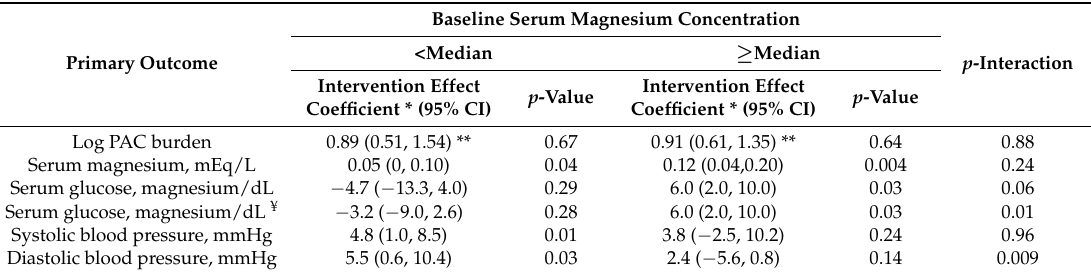
Table 4. Change in PACs and secondary endpoints (i.e., SBP, DBP, serum glucose, serum magnesium) according to treatment group, stratified by baseline serum magnesium